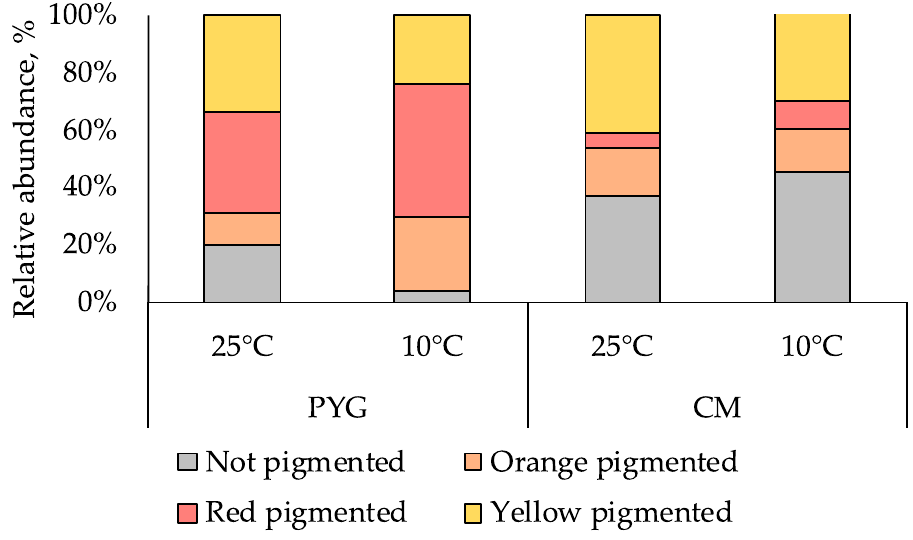
Figure 2. Proportion of pigmented colonies in the communities studied.